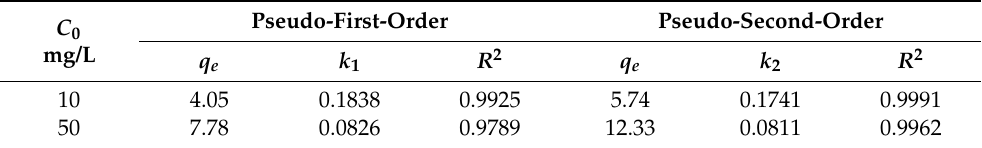
Table 1. The kinetics parameters for the adsorption of Cr(VI) by MHDB. Pseudo-First-Order Pseudo-Second-Order C 0 mg/L